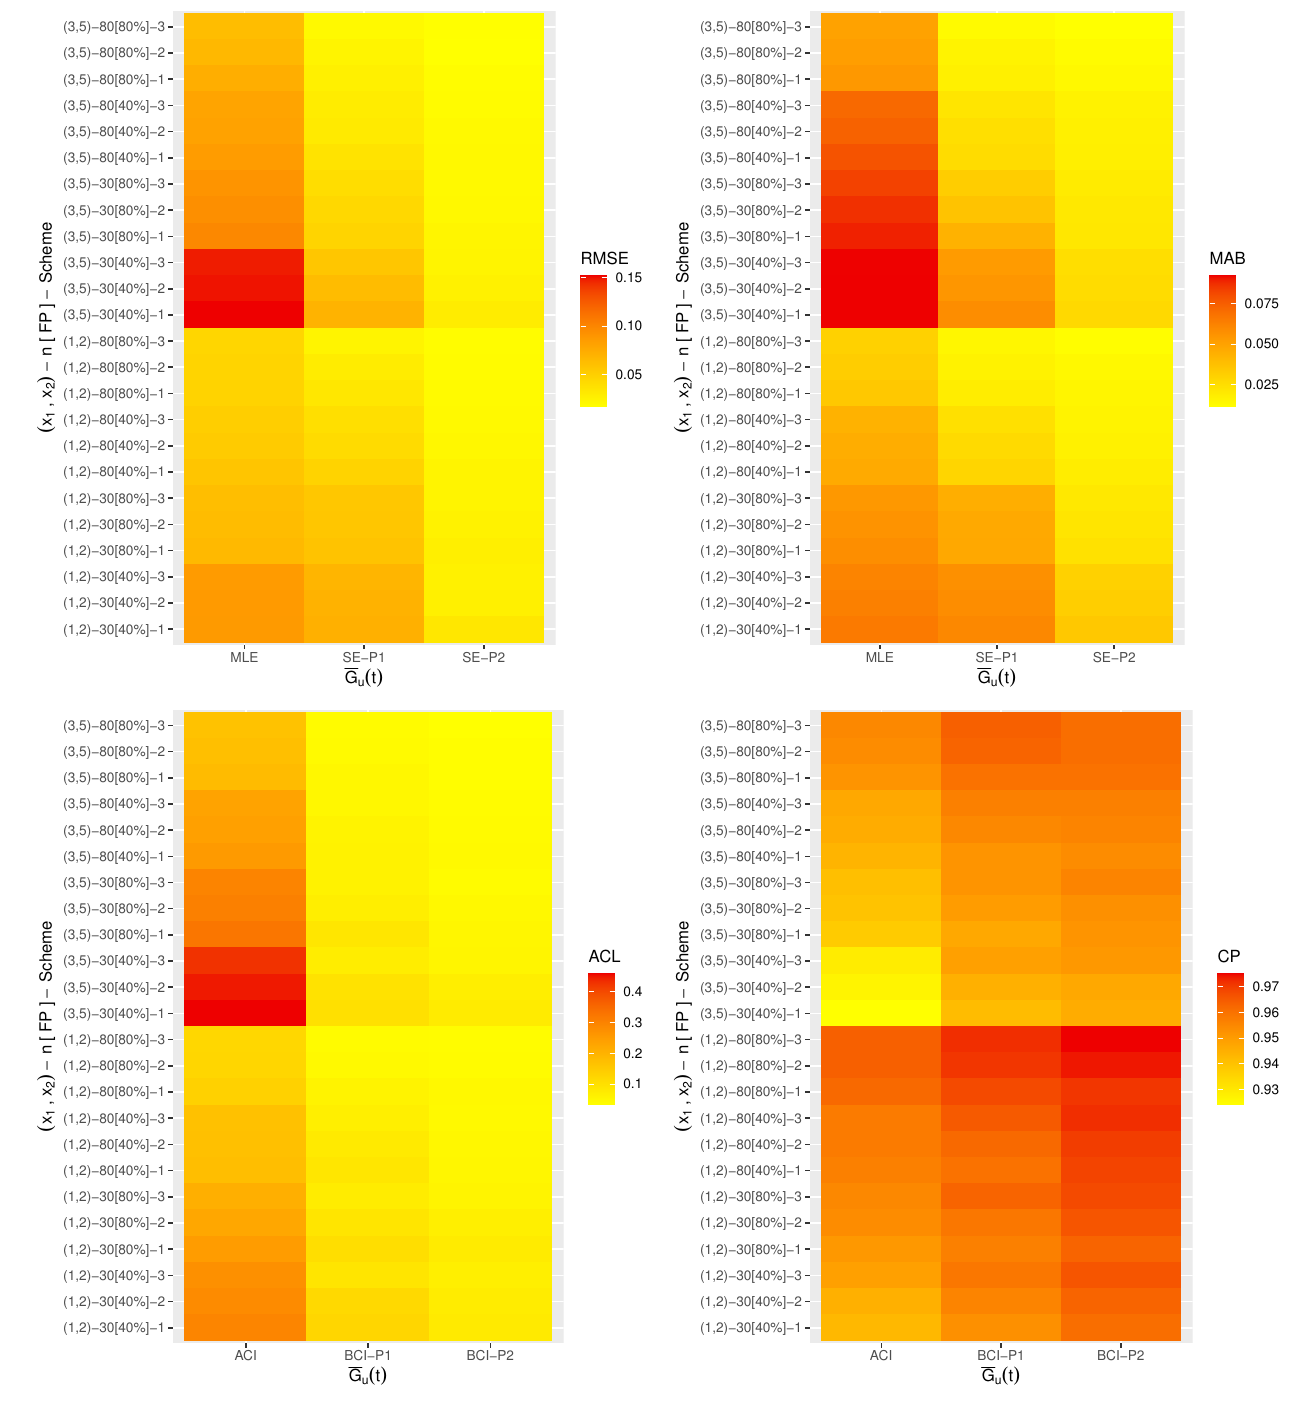
Figure 5. Heat map for the simulation results of G u ( t )